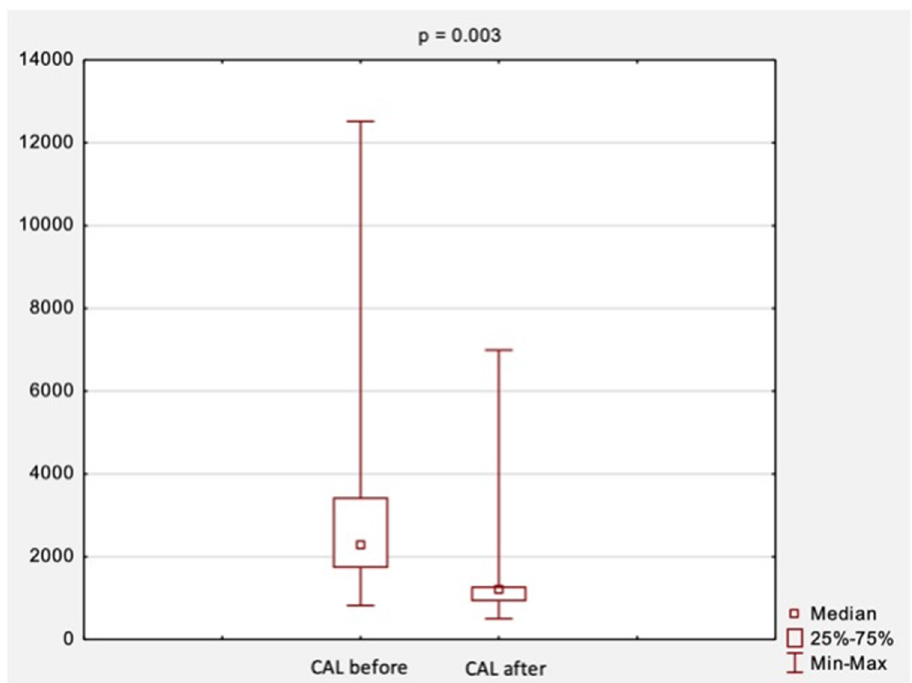
Figure 2. The comparison of CAL levels before and after surgical treatment. Abbreviations: CAL, calprotectin; p, level of statistical significance.